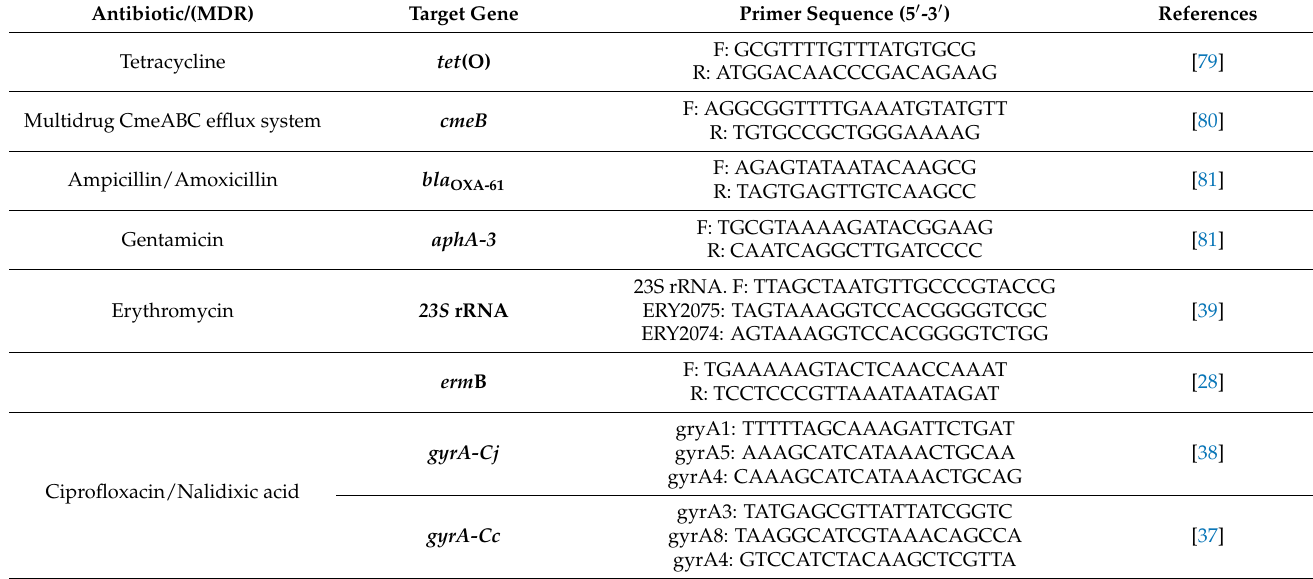
Table A2. Sequences of genes encoding antibiotic resistance investigated in Campylobacter